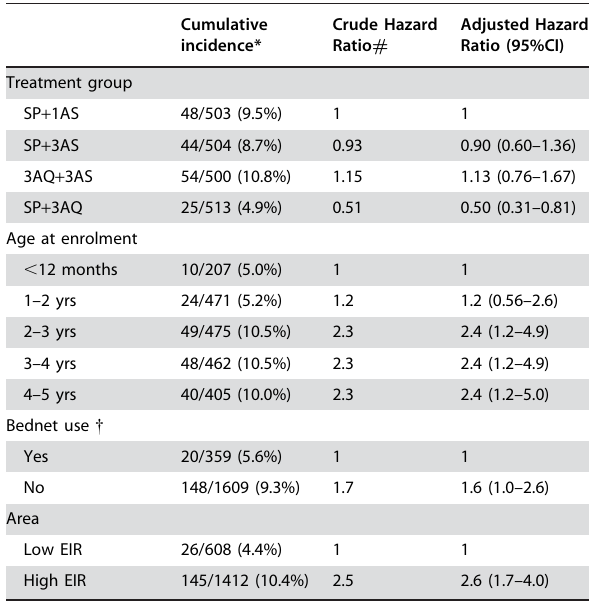
Table 2. Incidence of malaria by age, bednet usage, area